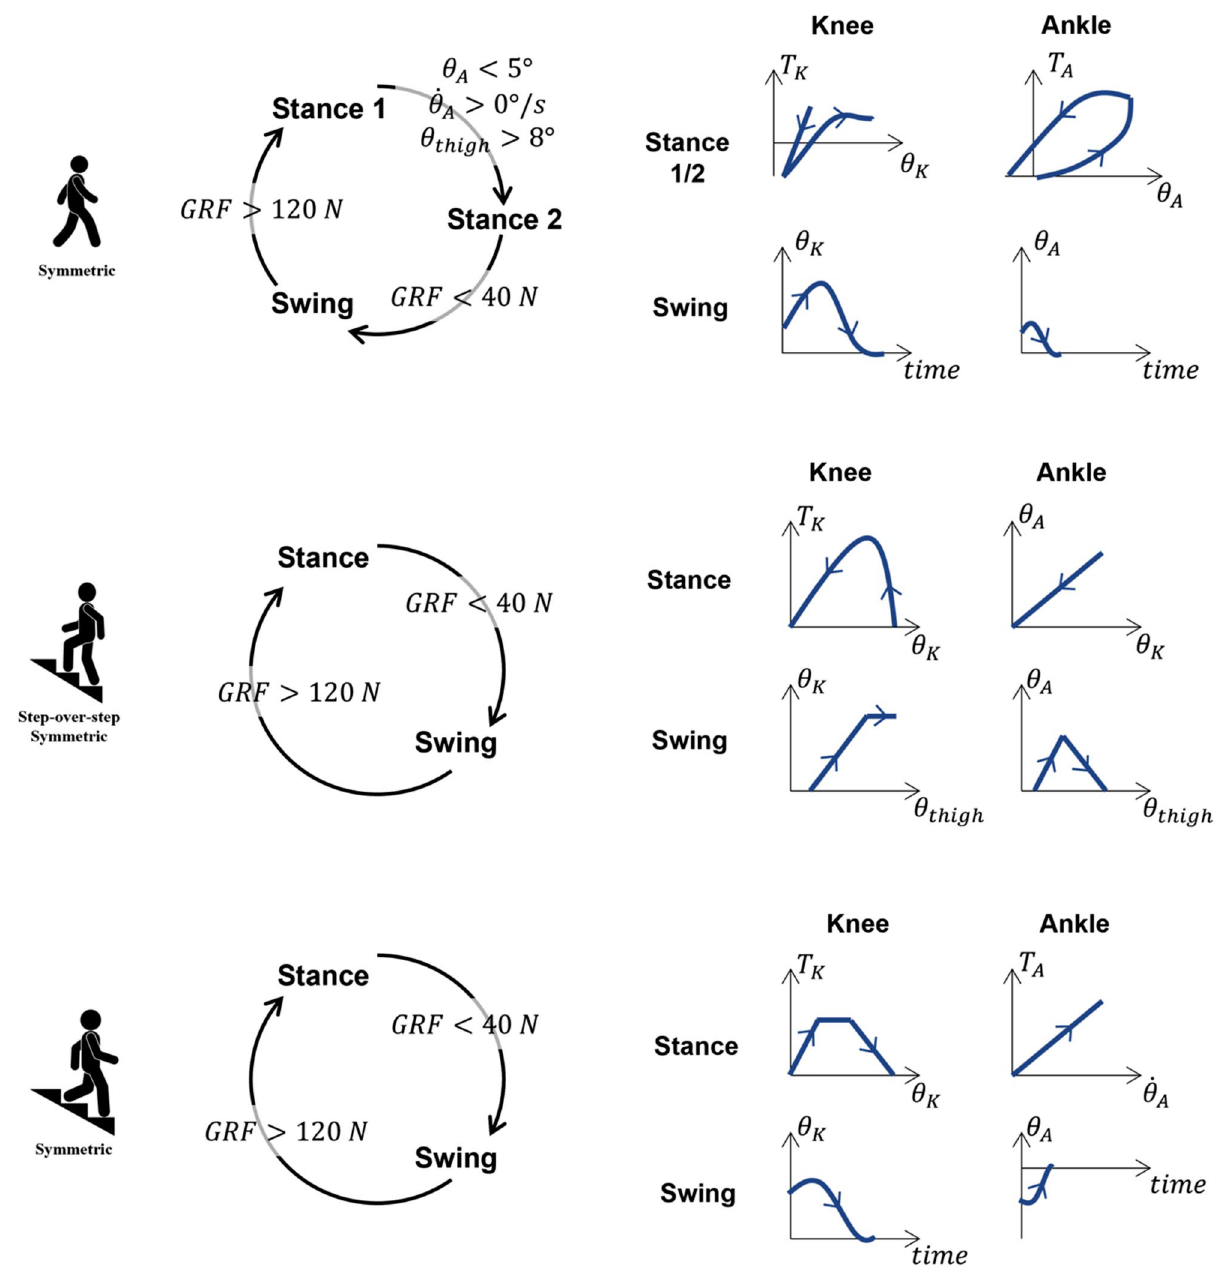
Figure 5. Control architecure of the Utah Bionic Leg. The schematic representation of the hierarchical architecture for the high and mid-level control implemented on the Utah Bionic Leg. Dedicated controllers are used for walking, stair ascent, and stair descent (top to bottom) using transition conditions between defined states, and the joint profiles for each state (left to right). Symbols T and θ denote joint torque and angle. Subscripts K and A denote knee and ankle